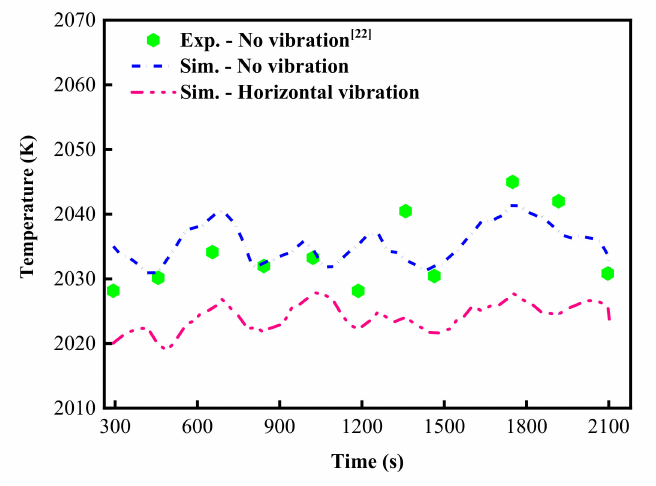
Figure 3. Comparison of the slag layer temperature between simulation and